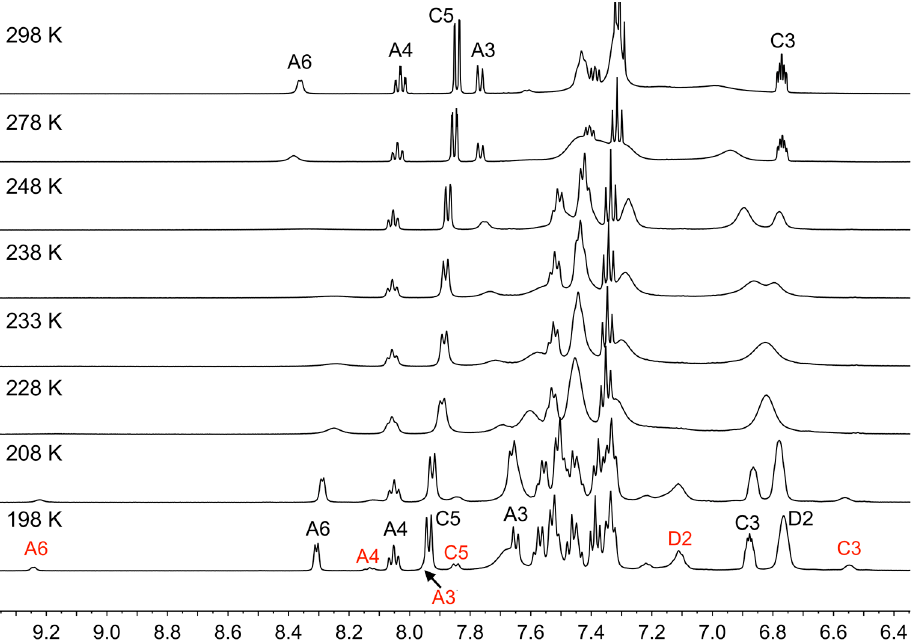
Figure 6. Aromatic region in the variable temperature 1 H NMR spectra of [Cu(xantphos)( t BuSPy)][PF 6 ] (500 MHz, acetone- d 6 ). At 198 K, the major species is represented by black labels, and minor species by red labels. See Materials and Methods Section for full assignment of major species.